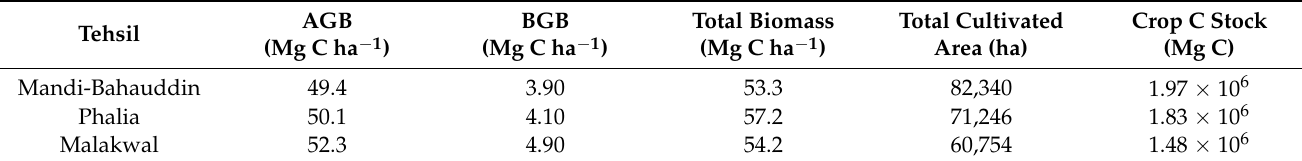
Table 8. Measured Carbon stock in Oryza sativa